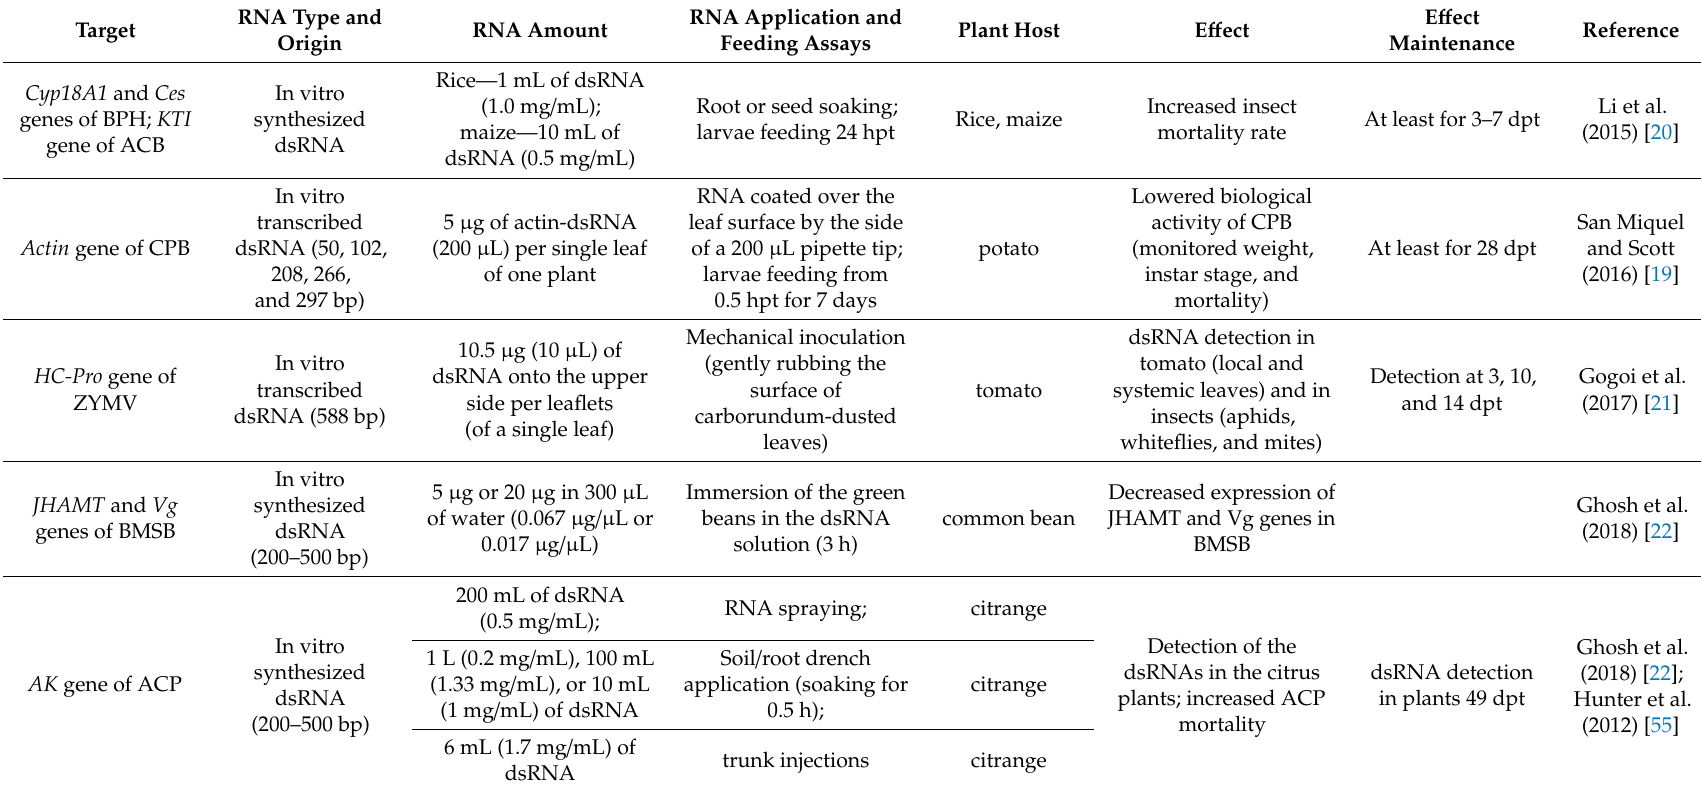
Table 2. Application of external RNAs for plant insect pest